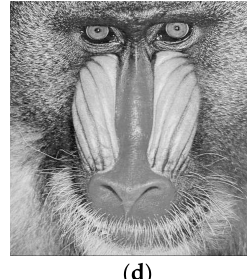
Figure 6. ( a ) Original baboon image; ( b ) watermark image; ( c ) scramble image; ( d ) watermarked baboon image. Table 5. Imperceptibility analysis.